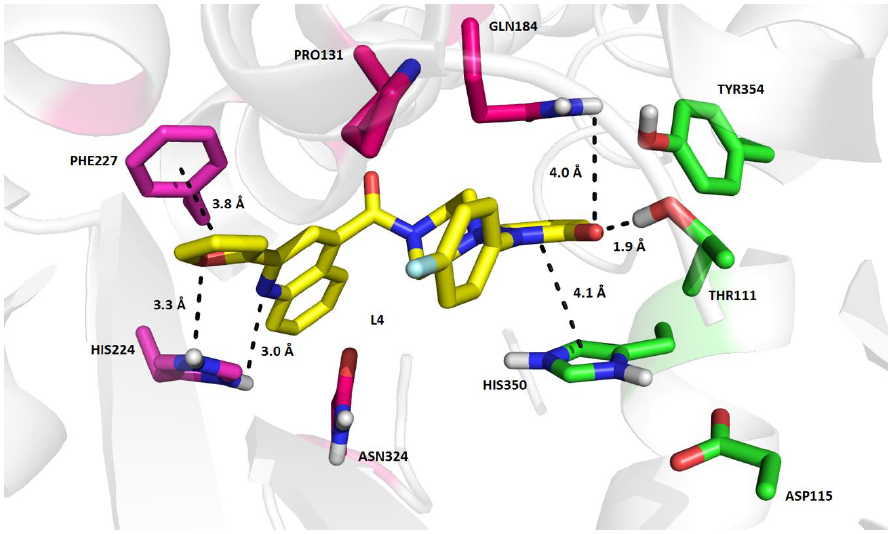
Figure 2. Predicted binding mode of L4 in the OX2R model (PDB ID: 4S0V) by AutoDock Vina. The green colored residues represent the putative agonistic tetrad proposed by Nagahara et al. [23]. Unfortunately, the binding affinities of L3 , L4 , L6 , L7 , and L10 for OX2R predicted by AutoDock Vina correlate only weakly with their logarithmized in vitro IC 50 values (R 2 = 0.24). Although the